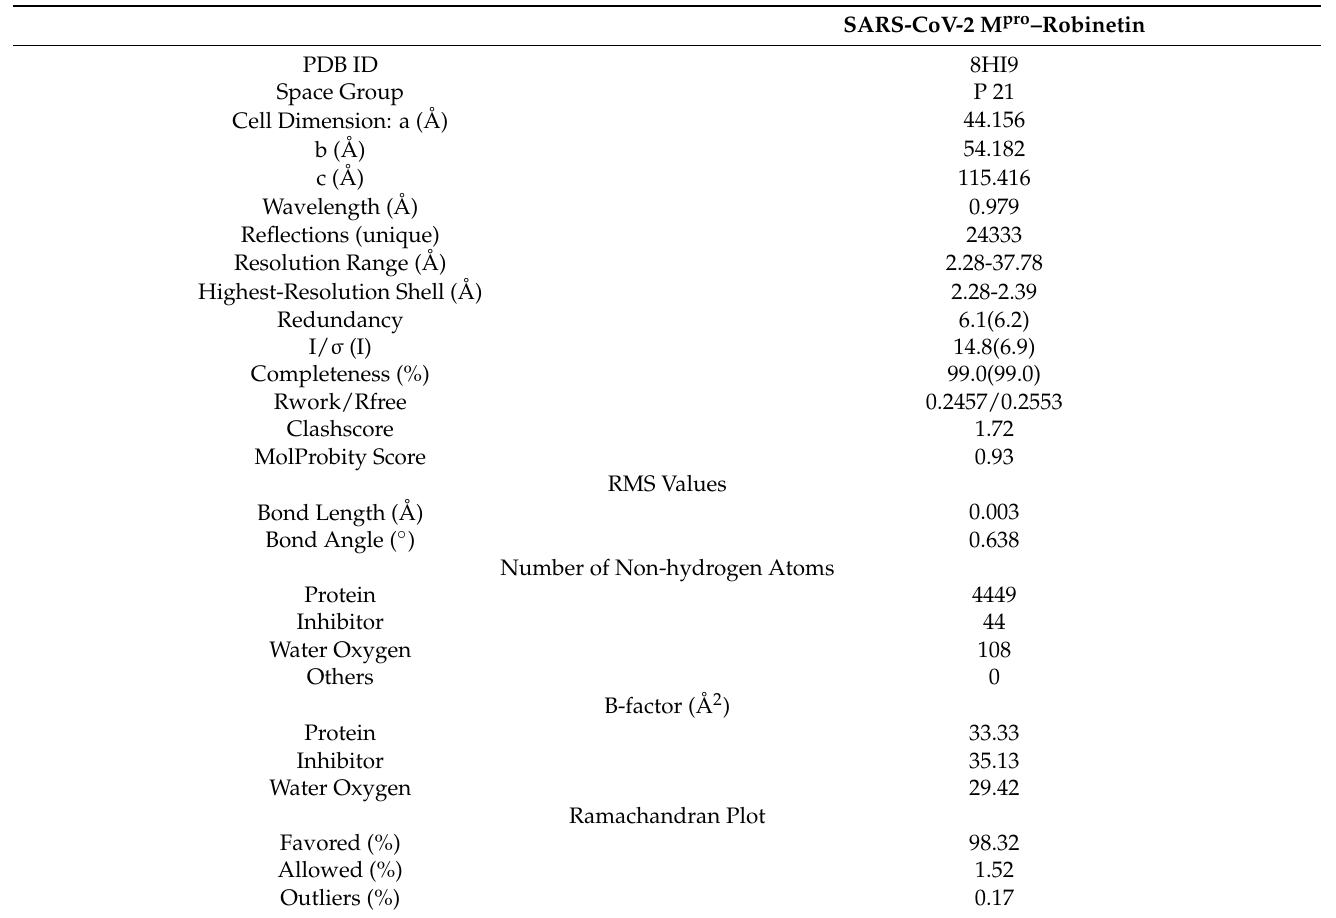
Table 2. Crystallography data collection and refinement